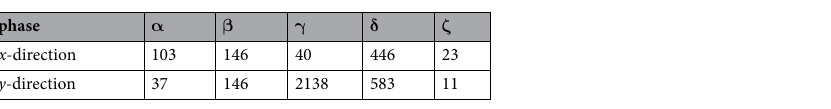
Table 4. The MFP value (in unit of nm) corresponding to 50% κ P accumulation for the five phosphorene allotropes.